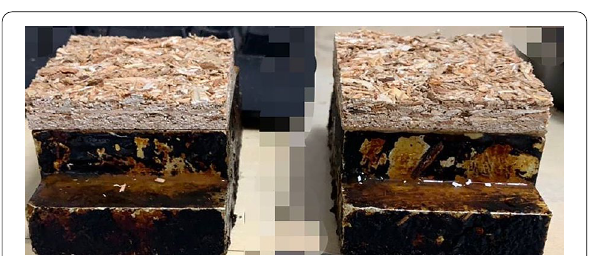
Fig. 3 Fracture position diagram of specimens after IB